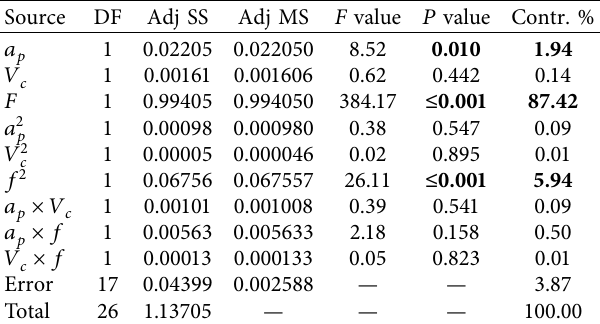
Table 6: Analysis of variance for surface roughness. Source DF Adj SS